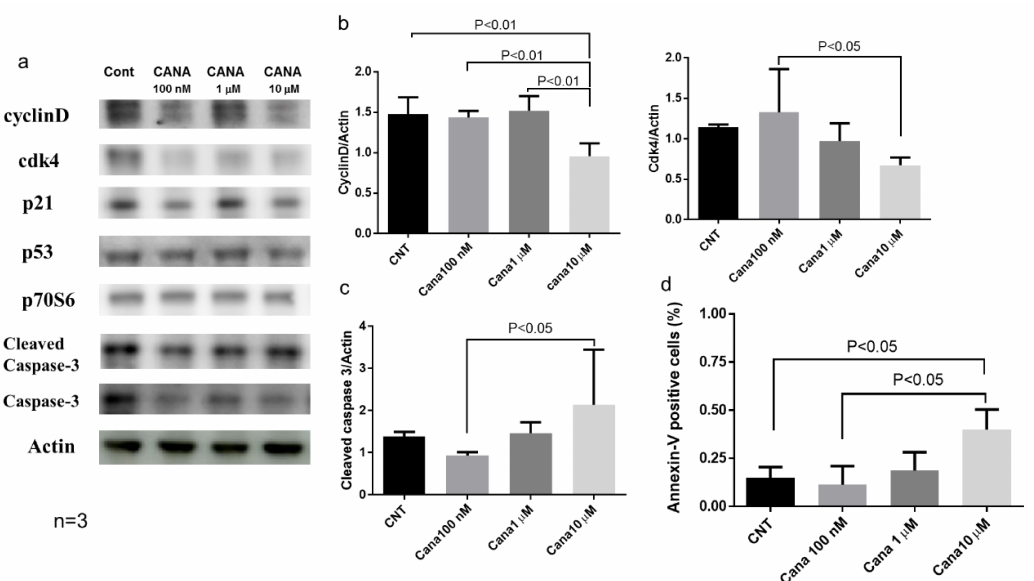
Figure 8. Canagliflozin attenuated proliferation of HCC by inducing cell cycle arrest and / or apoptosis in HepG2 cells. ( a ) Western blot analysis of cell-cycle regulated proteins and cleaved caspase-3 in HepG2 cells. ( b ) The protein expression of both cyclin D and CDK4 significantly reduced in treatment with 10 µ M canagliflozin. ( c ) Treatment with 10 µ M canagliflozin augmented the protein expression of cleaved caspase 3. ( d ) 10 µ M canagliflozin significantly increased the percentage of annexin V-positive